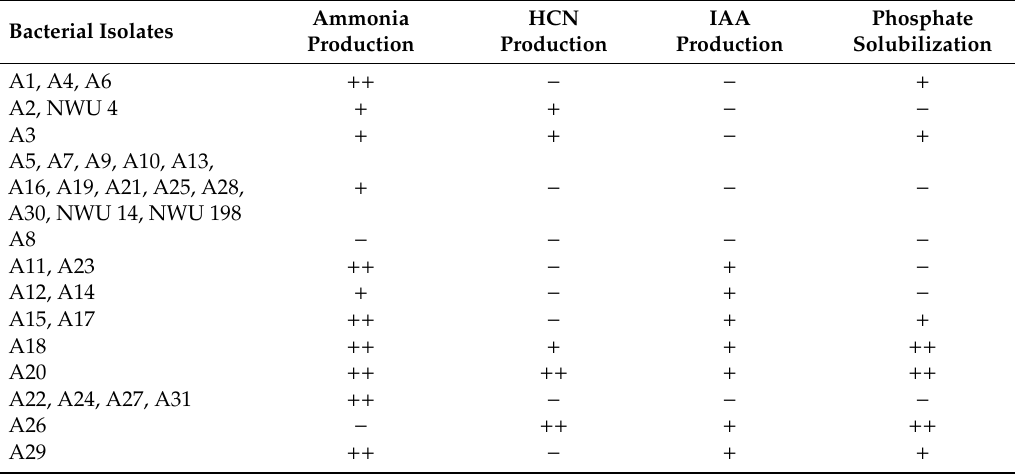
Table 1. Plant growth-promoting properties of bacterial isolates.